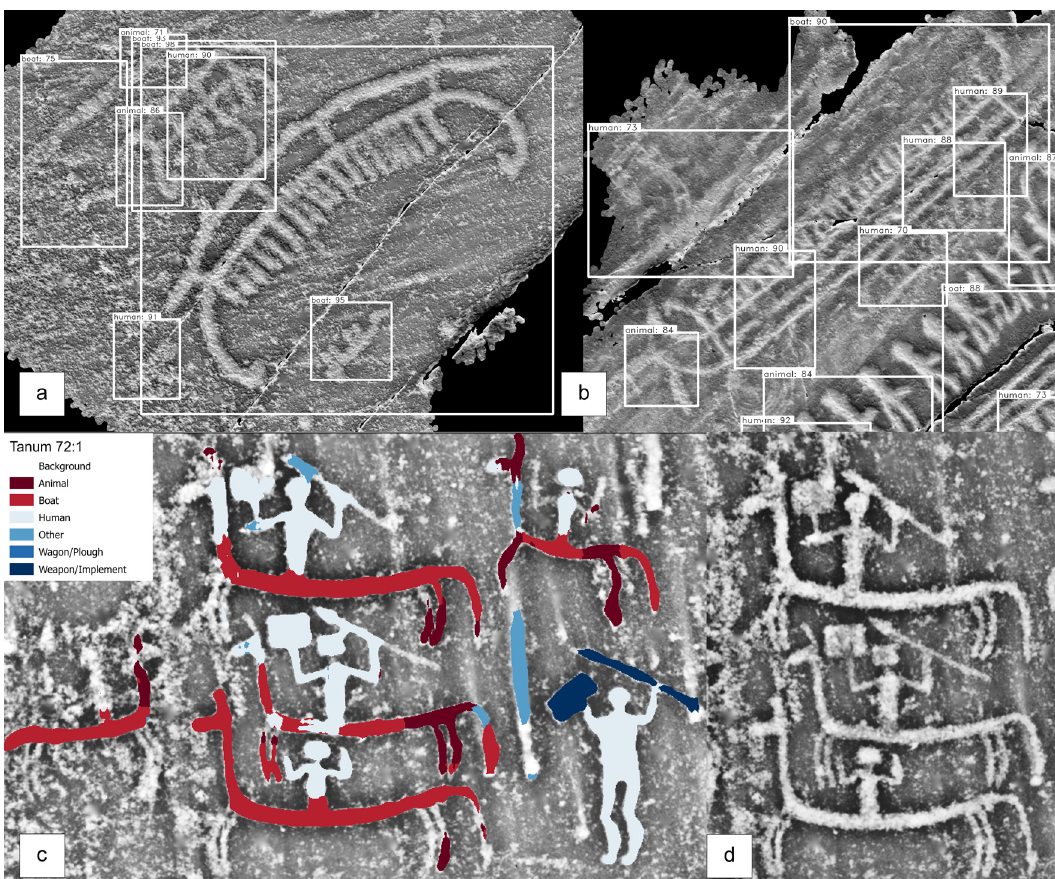
Figure 3: Examples of “ misclassi fi cations ” : ( a ) animal in the lower - right centre classi fi ed as a boat ( Tanum 25:1 ) ; ( b ) large boat with the left stem identi fi ed as animal ( Östra Eneby 23:1 ) ; and ( c ) DeepLabv3 + classi fi cation of horses in Litsleby ( Tanum 72:1 ) partially as animals ( orange ) and boats ( blue ) . The image was “ upside - down ” from a human point of view; ( d ) the images from Litsleby turned 180° to make the image better readable to modern observers. Classi fi ed image visualization of 3D model ( Horn et al., 2019, 2022 ) . Documentation by Henrik Zedig ( County Administrative Board in West Sweden )